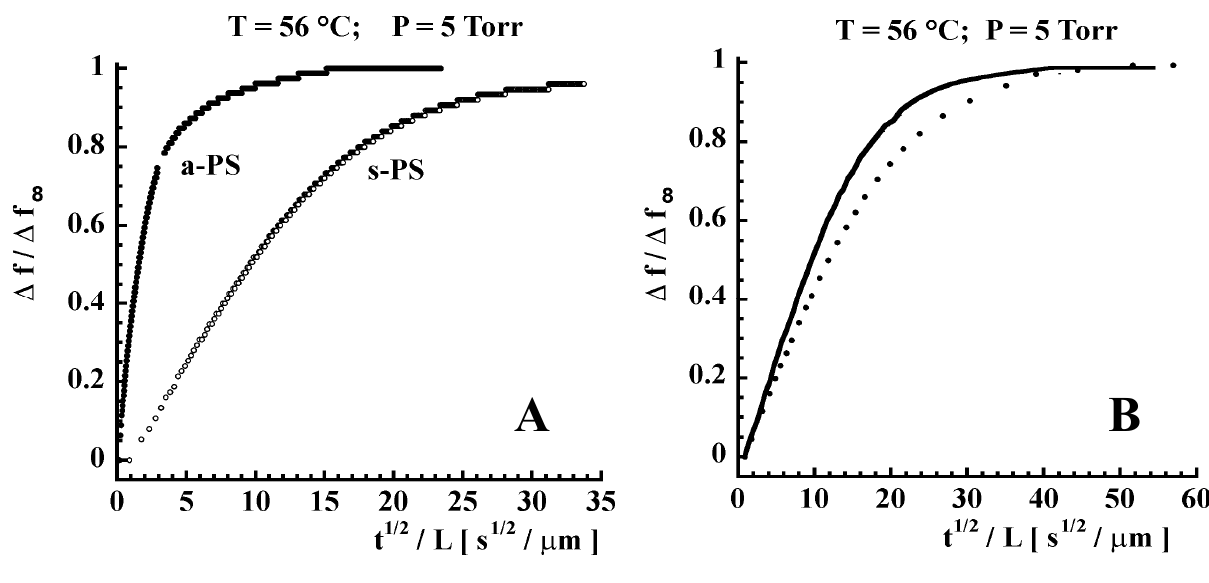
Figure 10. (A) Comparison of the response of QCM sensor for an a-PS and s-PS sensing layers. Data obtained at 56 °C and at a chloroform pressure of 5 Torr. (B) Reversibility of the sensor